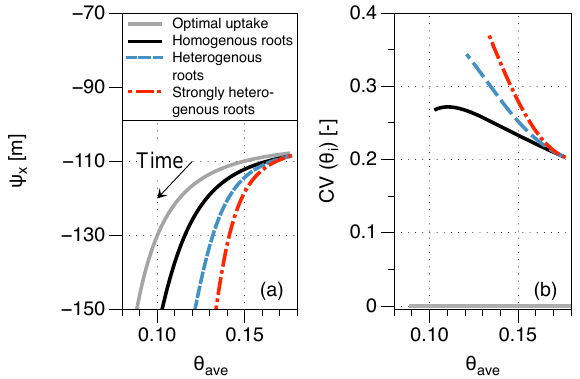
Figure 3. Model results of the simple model: (a) evolution of xylem potential over the course of root water uptake, (b) evolution of the coefficient of variation of soil water content during the simulation. Average initial soil water content is the same in all simulations. Only the unstressed uptake is shown. The time axis has been re- placed by average volumetric soil water, which evolves parallel with time in this constant-flux